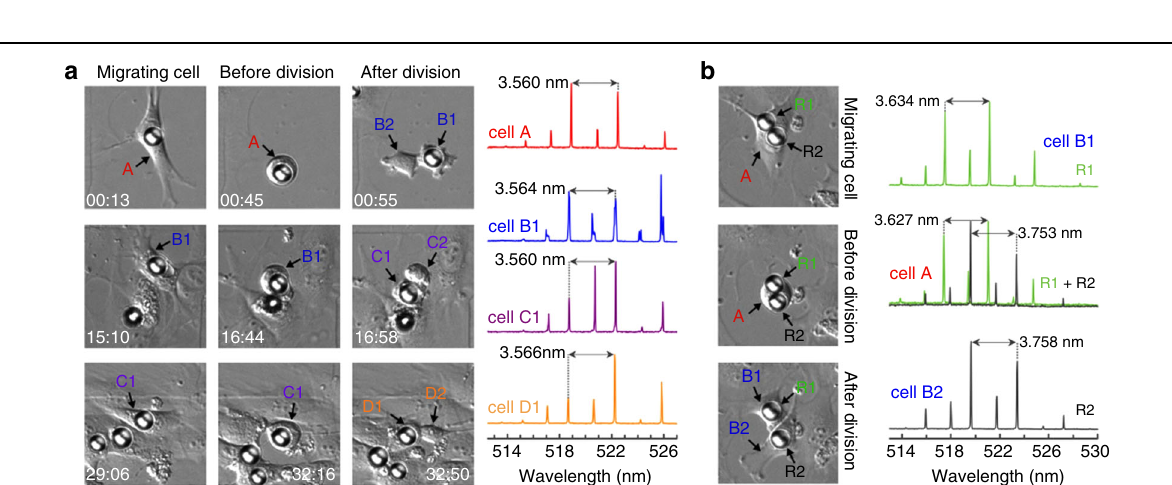
Fig. 7 Long-term tracking of 3T3 fi broblast cells over several cell generations using internalised lipofectamine-treated polystyrene active microresonators. Mother cells are denoted A (red), and subsequent daughter generations are labelled B (blue), C (violet) and D (orange). a Left: differential interference contrast (DIC) images of a WGM laser within a migrating cell before, during, and after three cycles of cellular division. The time stamps indicated in the images are in hours:minutes and represent the period elapsed after the fi rst lasing spectrum. Right: lasing spectra of the WGM resonator recorded during the migratory period, i.e., between cell division events. Arrows mark the free spectral range (FSR) between two neighbouring TE modes. b Left: tagging of both daughter cells (B1 and B2) from a mother cell carrying two intracellular lasers (R1 and R2). Right: lasing spectra of resonators inside the mother cell (centre, recorded separately for each resonator but plotted together) and after cell division (top/ bottom). All DIC images show an area of 100 × 100 μ m 2 . Reproduced from ref.